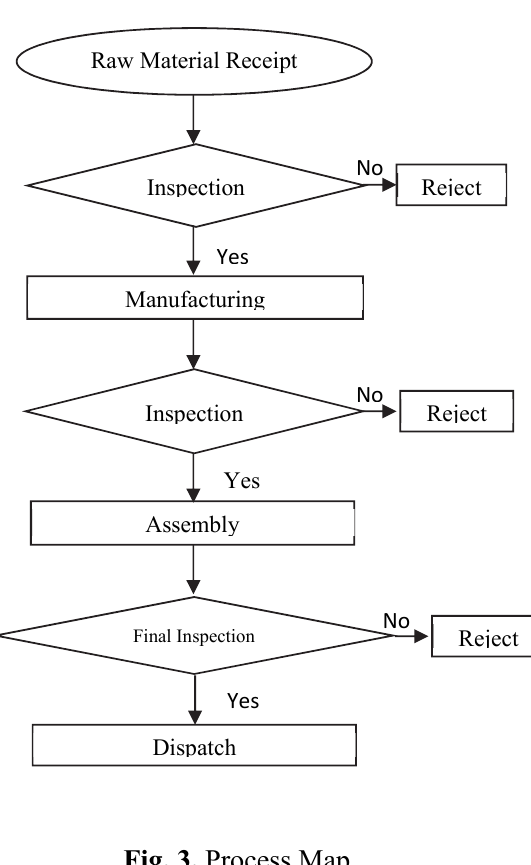
Fig. 3. Process Map